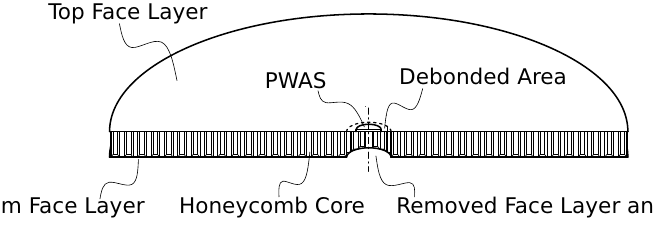
Figure 1. Circular sandwich panel with central face layer debonding and applied PWAS (cut and non-scaled